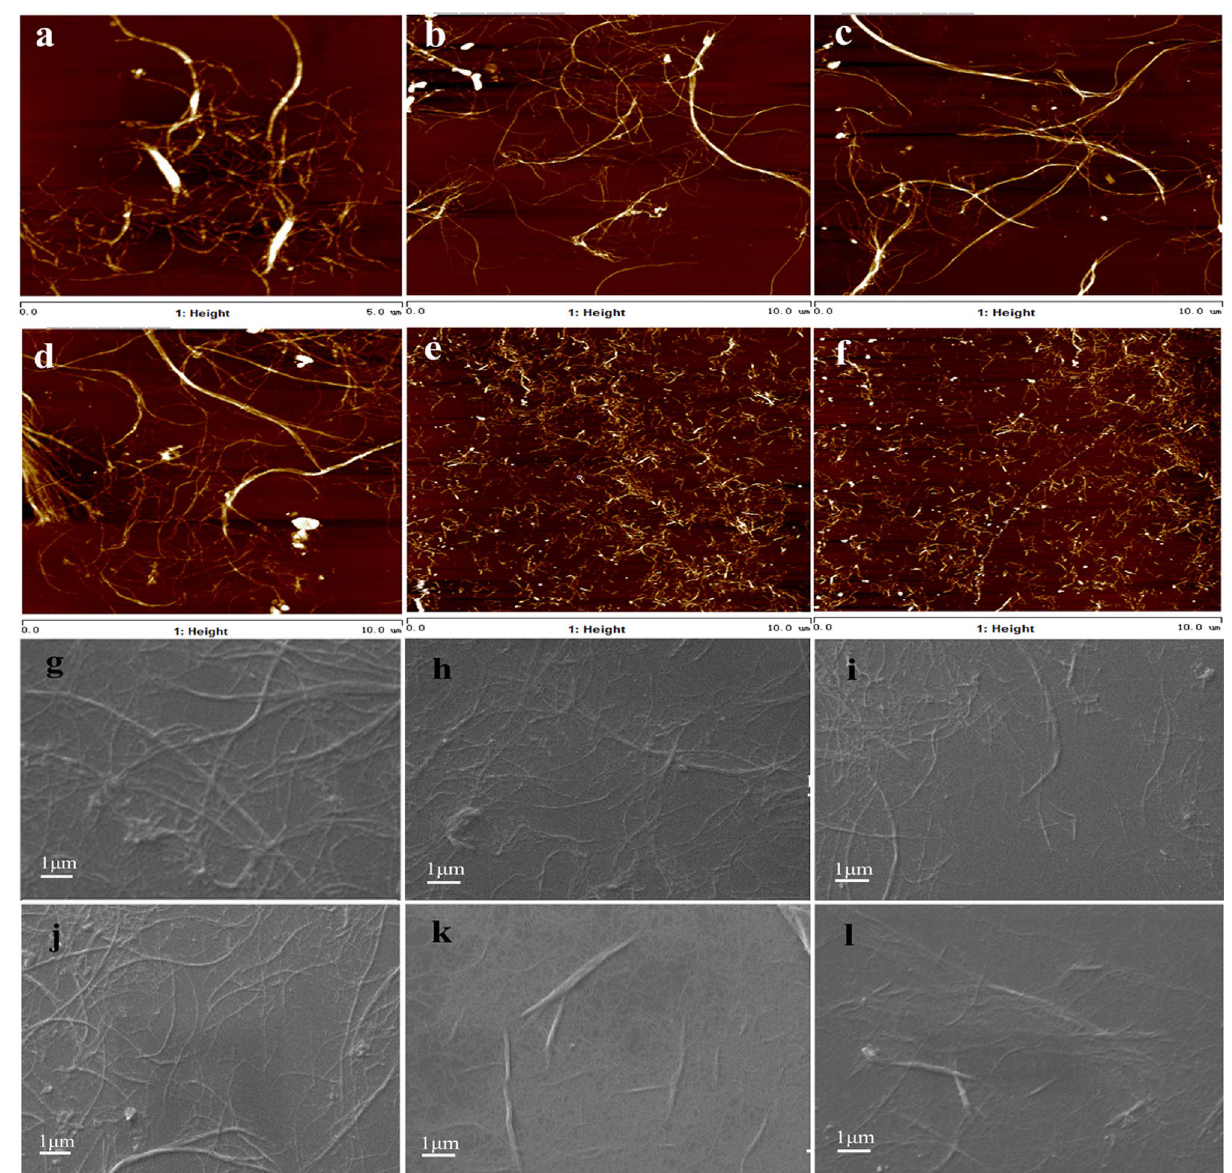
Figure 2. Morphologies of CNFs prepared by different methods. AFM height images: ( a ) EG-CNF1, ( b ) GH-CNF8, ( c ) GH-CNF10, ( d ) GH-CNF15, ( e ) TE-CNF1, ( f ) TE-CNF1; SEM images: ( g ) GH-CNF8, ( h )